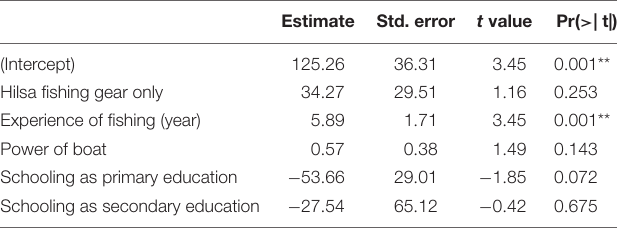
TABLE 4 | Determinants that affect the income of fishermen who work as skippers or boat owners in hilsa fisheries, as derived from the fishers’ survey. Estimate Std. error t value Pr( > | t|)